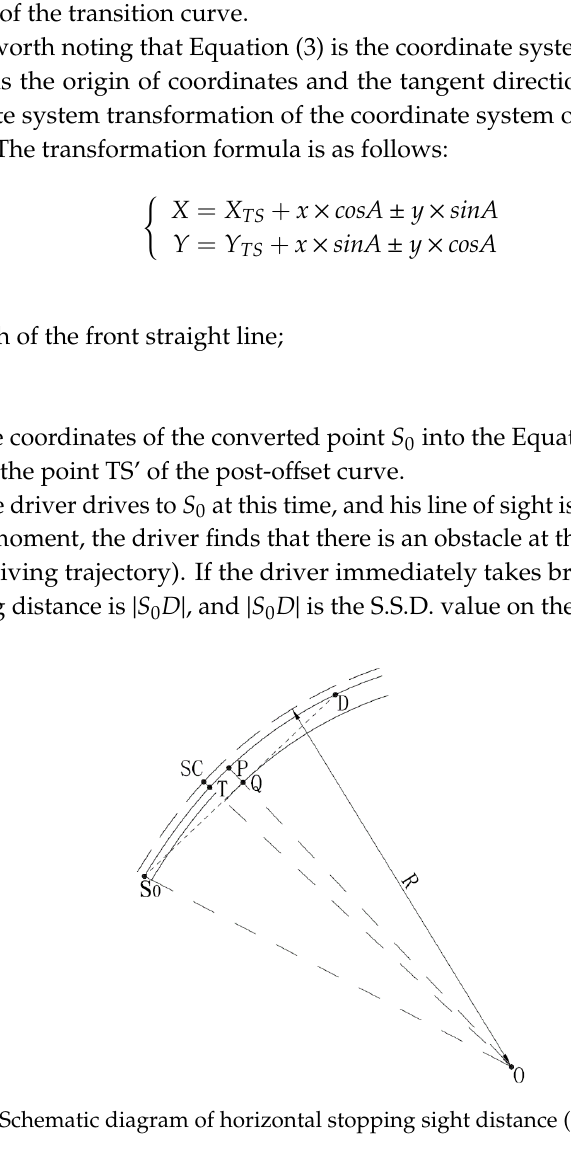
Figure 3. Schematic diagram of the tangent offset method.